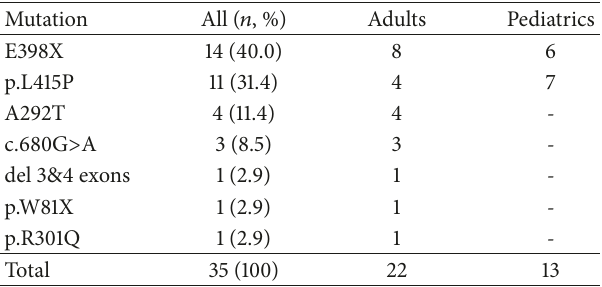
Table 1: GLA gene mutations in women with FD ( 𝑛 = 35